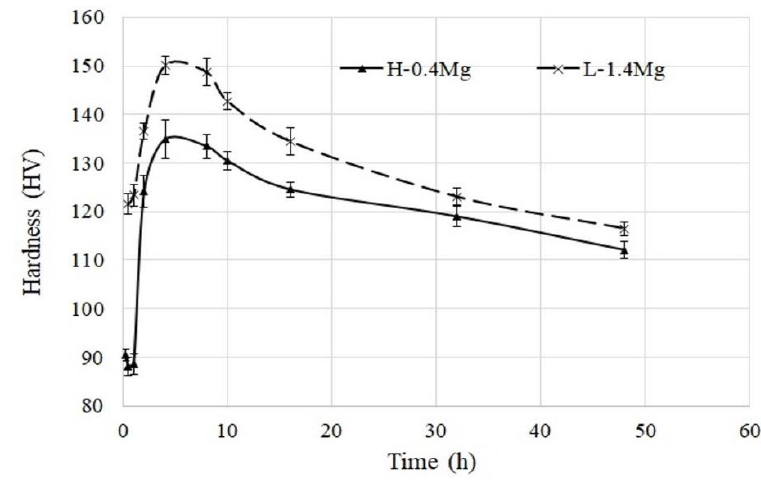
Figure 1. Evolution of microhardness of L-1.4Mg and H-0.4Mg alloys as a function of ageing time after solution treatment at 180 °C followed by quenching at room temperature (RT).